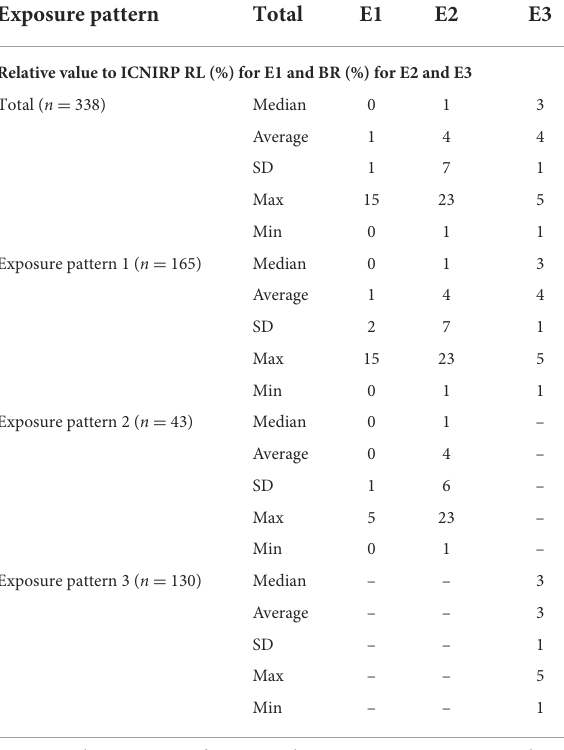
TABLE 5 Summary of exposure indices based on mid-term exposures (D1–D3) among library